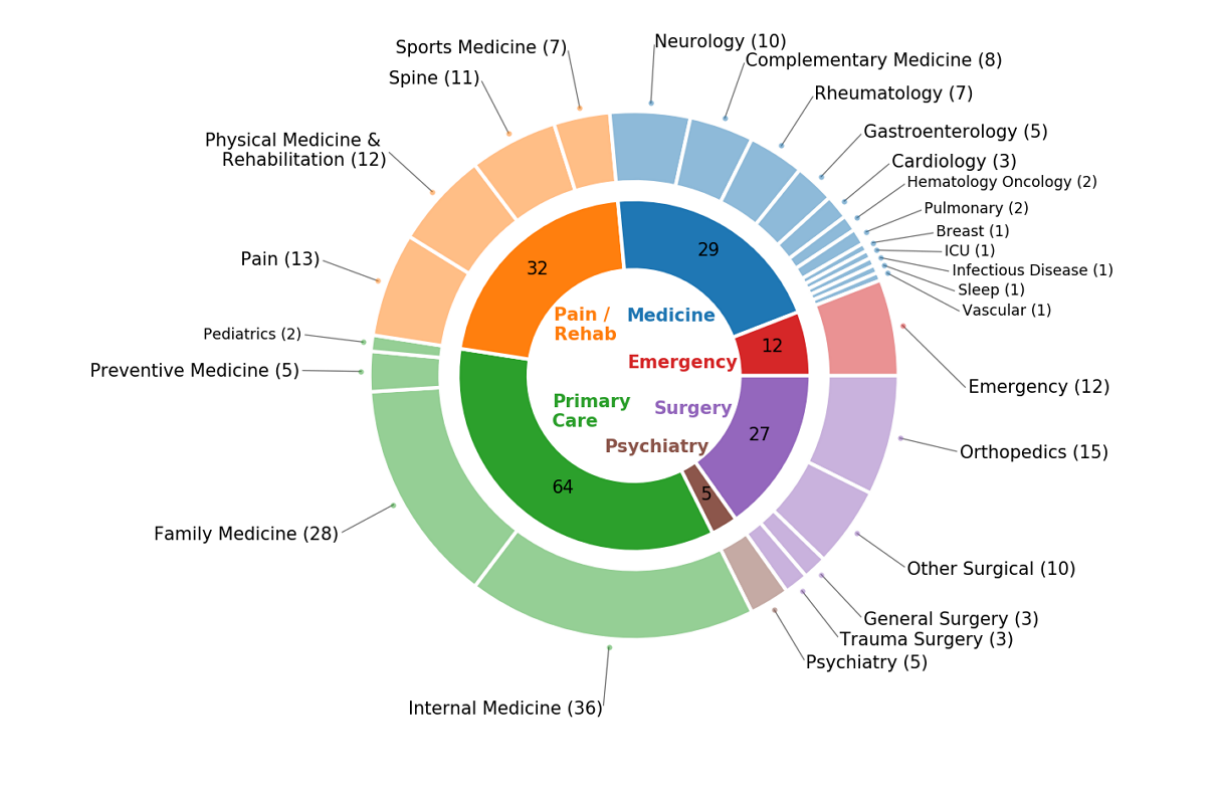
Figure 4. Counts of the annotated pain episodes by specialty. The inner circle represents the broader specialty category; the outer circle hosts the individual specialties under each category. Each quantity simply indicates how many episodes out of the 94 were cared for by the corresponding specialty or category. Note that an episode could be cared for by more than one specialty, so the counts involve overlaps and the sums may not match across. ICU: intensive care unit; Rehab: rehabilitation.